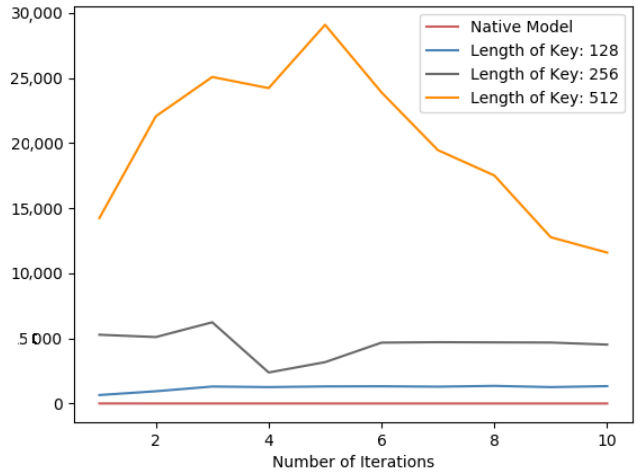
Figure 8. Per-iterations time spent on the MNIST dataset for different key lengths.